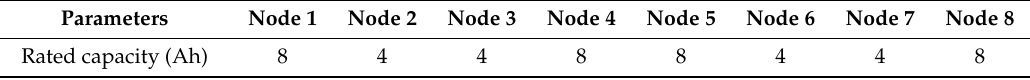
Table 3. Capacities of 8 ESs in fast discharging and charging simulation.